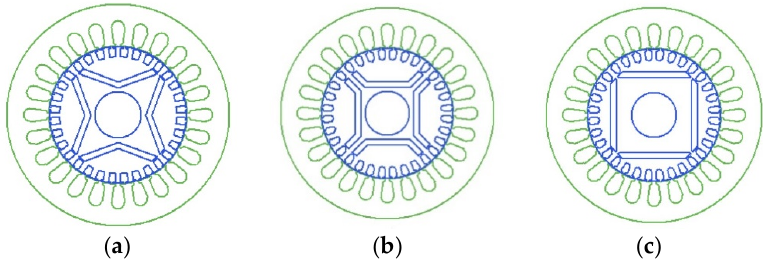
Figure 1. Typical rotor configurations for line start permanent magnet motors (LSPMM) [26]: ( a ) Type 1; ( b ) Type 2; ( c ) Type 3 [26].